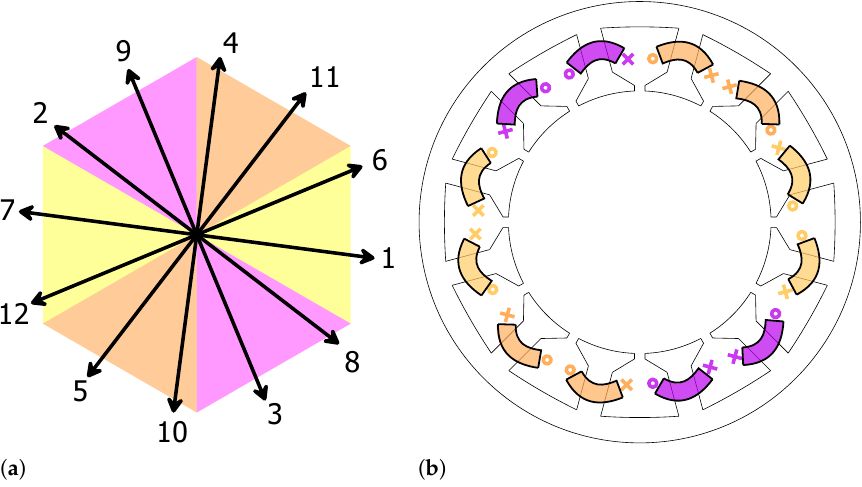
Figure 17. Star of slots and winding connections for 12 − slots / 10 − poles motor. ( a ) Star of slots. ( b )